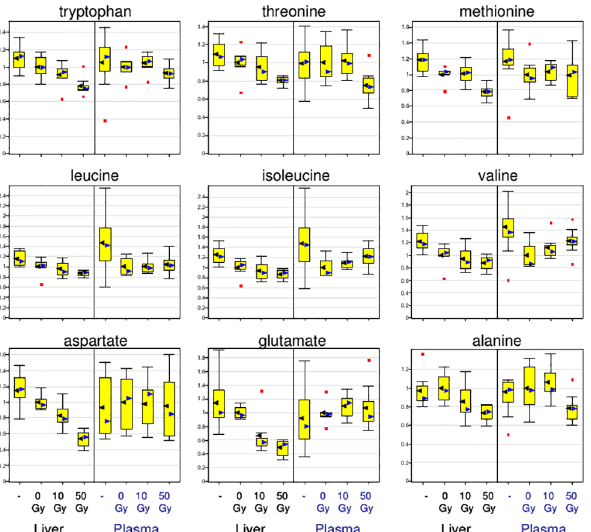
Fig 12. Comparative response of liver and plasma amino acid to irradiation. The relative levels of most amino acids were significantly reduced in mouse liver at 24 h after WLI. Decreased levels of amino acids in the liver after radiation treatment could reflect an increase in protein synthesis or their utilization for energy. Alternatively, decreased levels may result indirectly from an increase in cell volume due to osmotic stress- related changes following